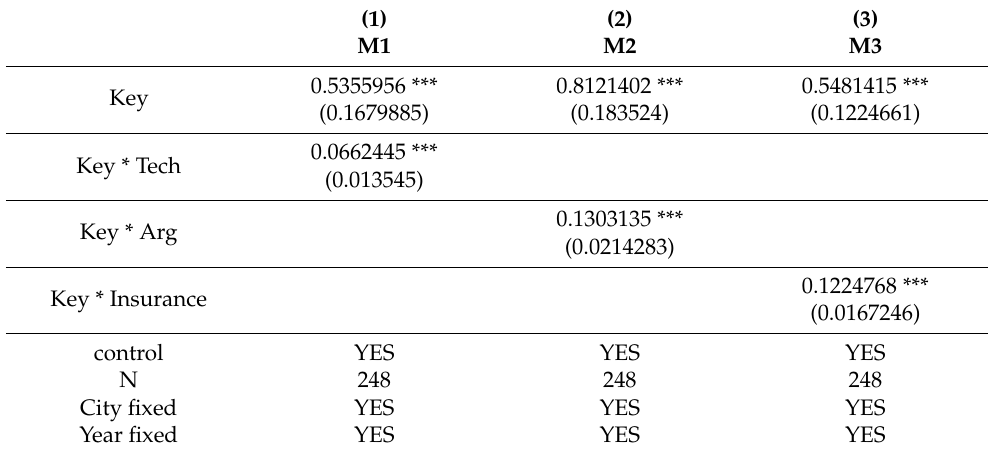
Table 6. Analysis of conduction